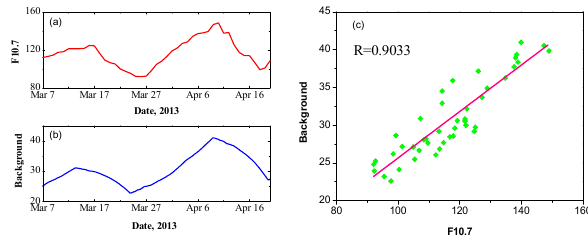
Fig. 5. (a) Solar activity index F10.7 time series. (b) Decomposed Figure 5. (a) Solar activity index F10.7 time series. (b) Decomposed TEC background time TEC background time series. (c) The Pearson correlation between series. (c) The Pearson correlation between the background and F10.7. the background and F10.7.